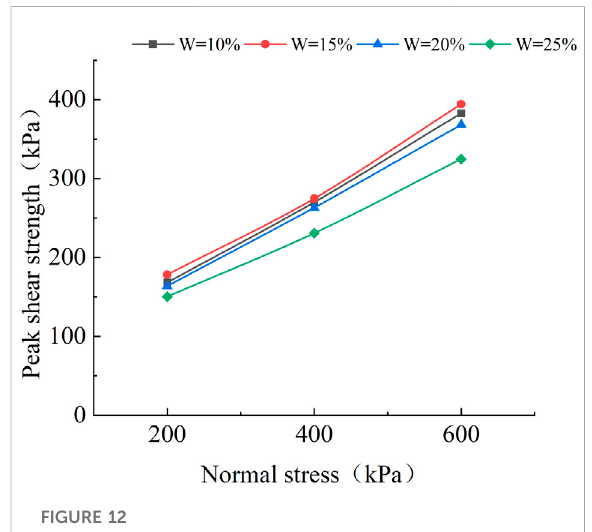
FIGURE 12 Peak shear strength under different normal stresses.